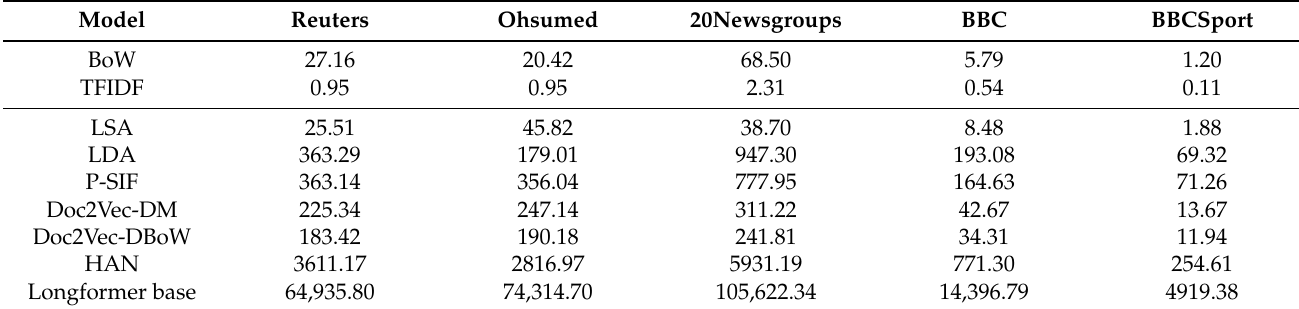
Table 2. Average total training and inference time in